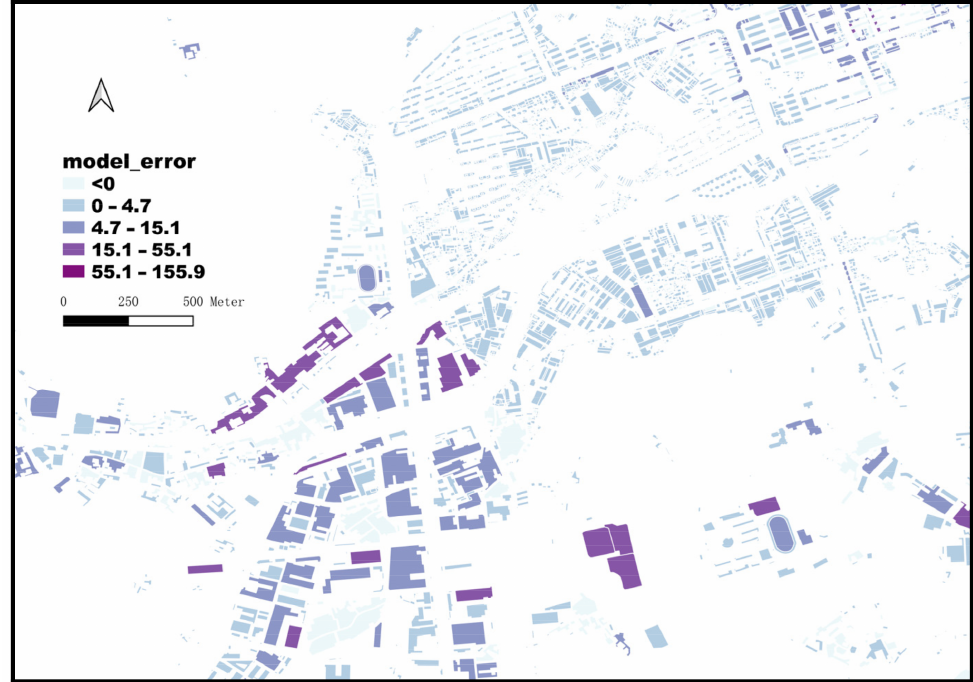
Figure 7. The error of the RF